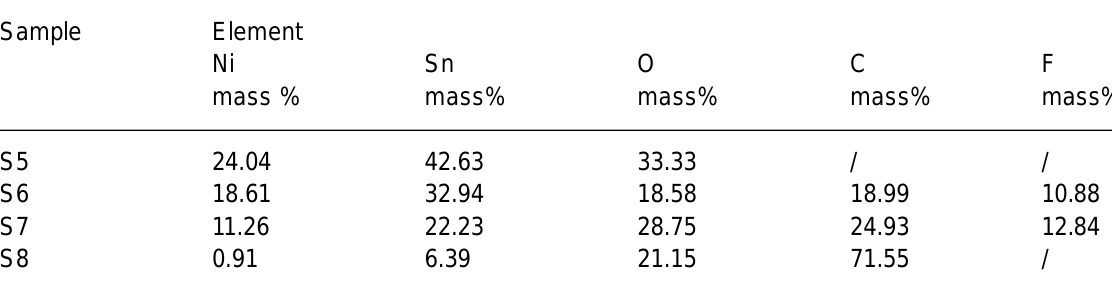
Table 2. EDS results for the elemental composition of the Ni-Sn nanoparticles.